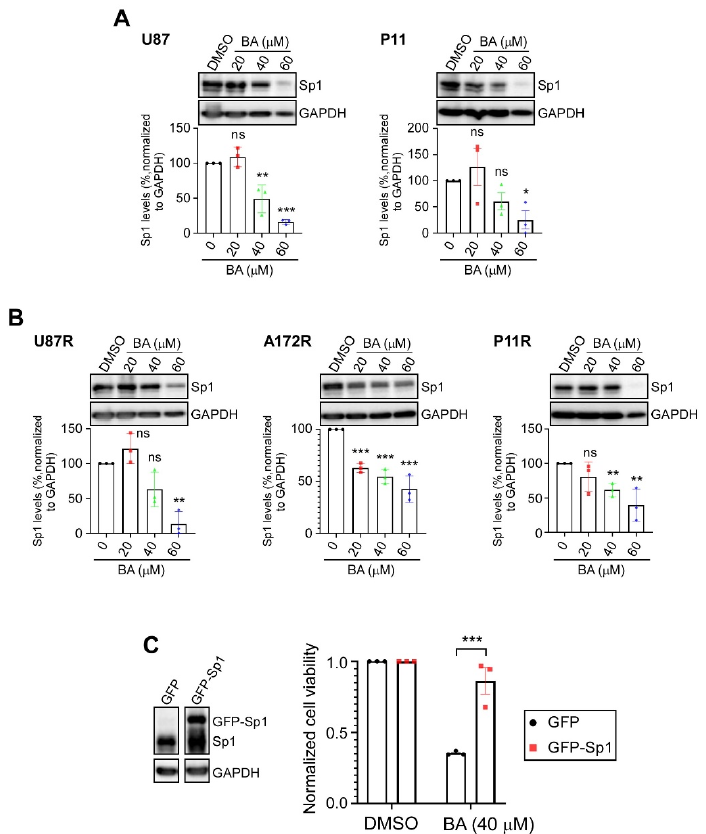
Figure 3. BA reduces Sp1 levels in GBM cells. ( A , B ) Cells treated with different concentrations of BA for 2 days. After treatment, Sp1 levels were determined by Western blotting. ( C ) Green fluorescent protein (GFP)- or GFP-Sp1-overexpressing U87MG cells treated with BA for 2 days. Cell viability determined by MTT assay. Data presented as means ± standard deviations (t-Test: * p < 0.05, ** p < 0.01, and *** p < 0.005; ns: not significant). For more details on Western blot, please view Supplementary